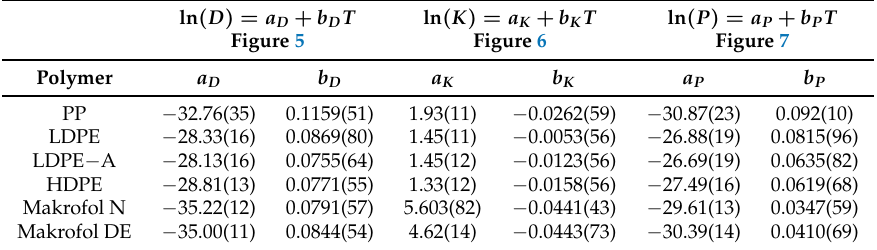
Table 4. Parameters of the linear fits applied to the experimental data shown in Figures 5–7, respectively. ln ( D ) = a D + b D T ln ( K ) = a K + b K T ln ( P ) = a P + b P T Figure 5 Figure 6 Figure